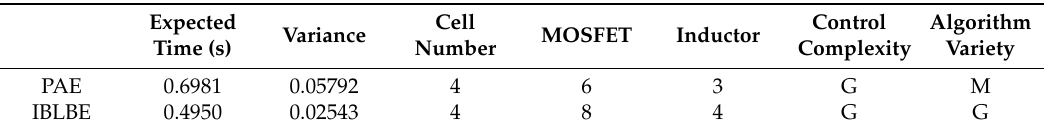
Table 3. The comparison between PAE and IBLBE in 4 cells battery string (G: Good; M: Marginal; P: